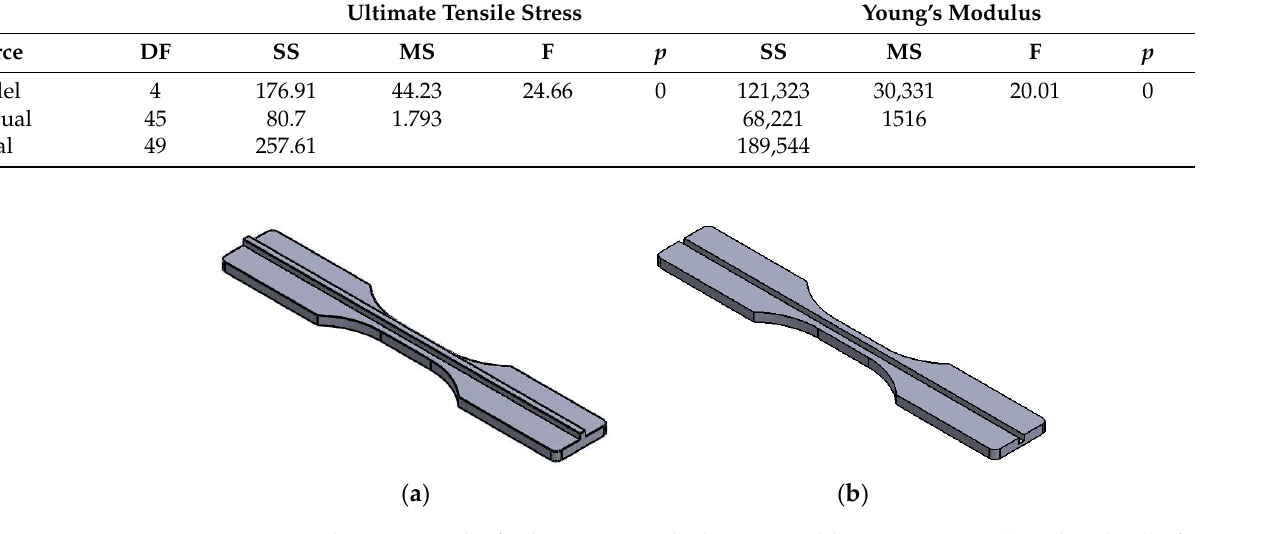
Figure 8. Representative stress-strain curves for tensile test amongst all HYM samples with joint configurations. Table 7. ANOVA of the model for Ultimate Tensile Stress and Young’s Modulus. Degree of Freedom for DF, Sum of Squares for SS, Mean Square for MS, F-Ratio for F, and p -Value for p .